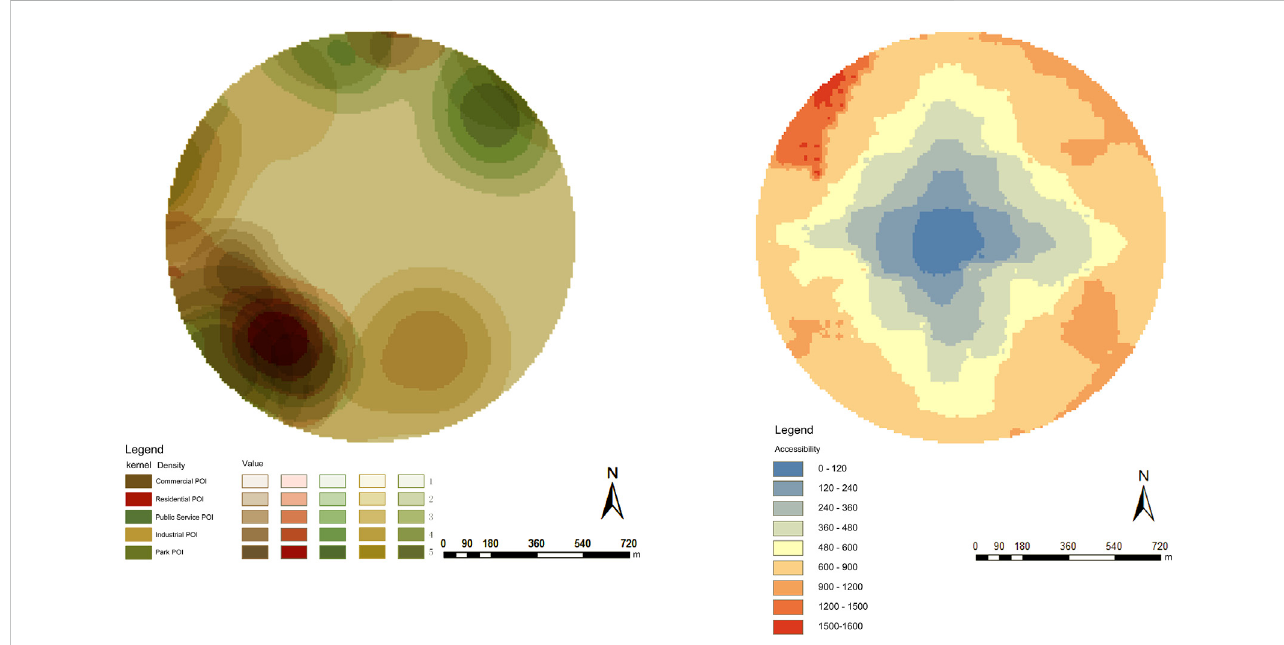
FIGURE 6 Analysis of POI kernel density (left) and accessibility (right) around Lu Xiao Station.